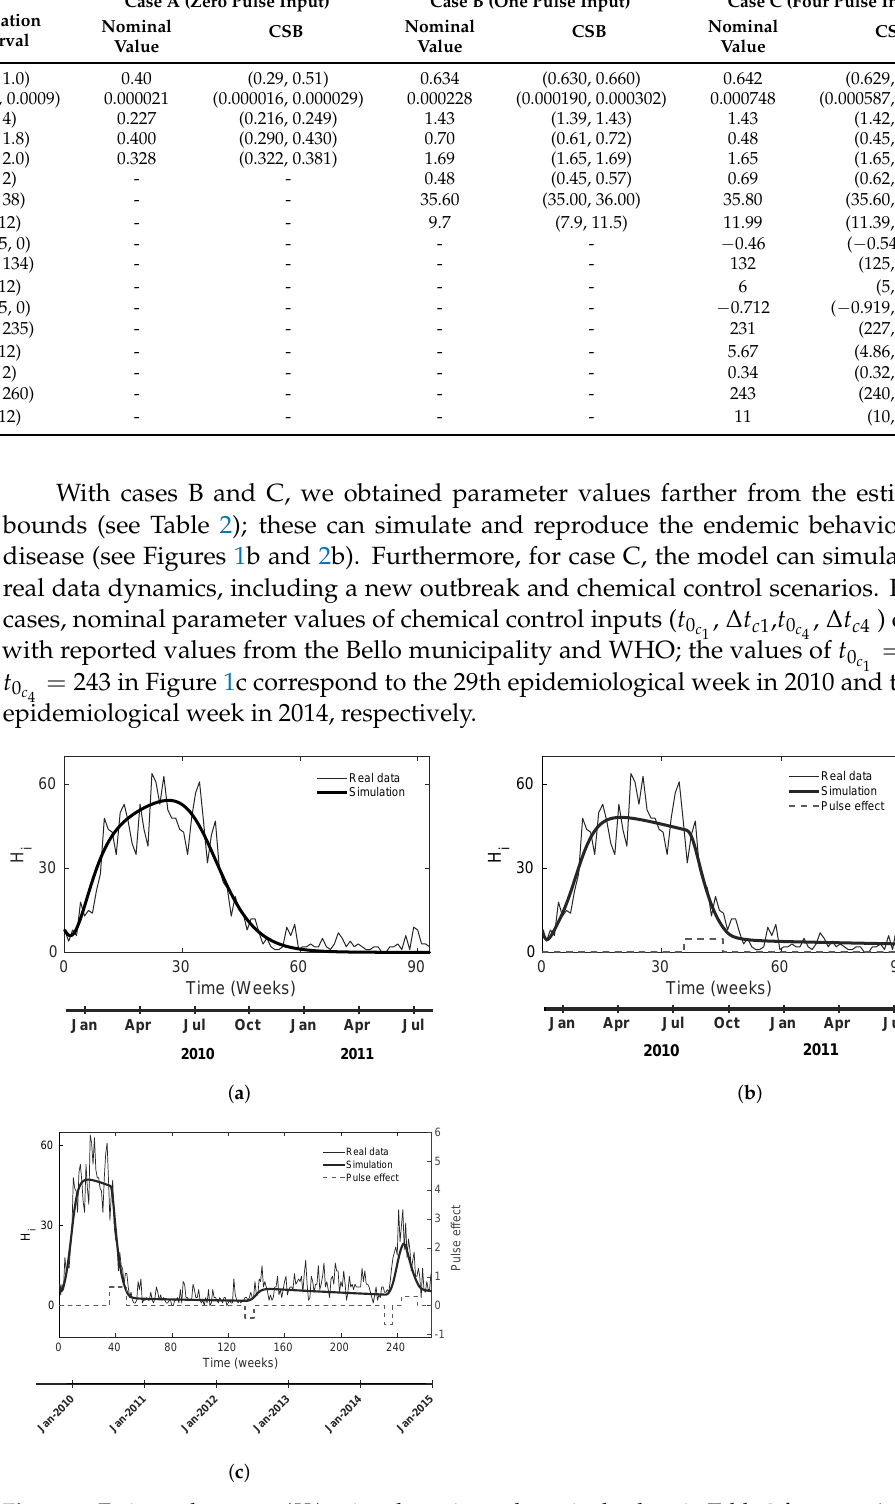
Figure 1. Estimated outputs ( H i ) using the estimated nominal values in Table 2 for cases A, B, and C. The pulse-type input has the same units as the mortality rate (mosquitoes per week). ( a ) Estimated output for one dengue outbreak without pulse-type input; ( b ) estimated output for one dengue outbreak with one pulse-type input; ( c ) estimated output for two dengue outbreaks with four pulse- type